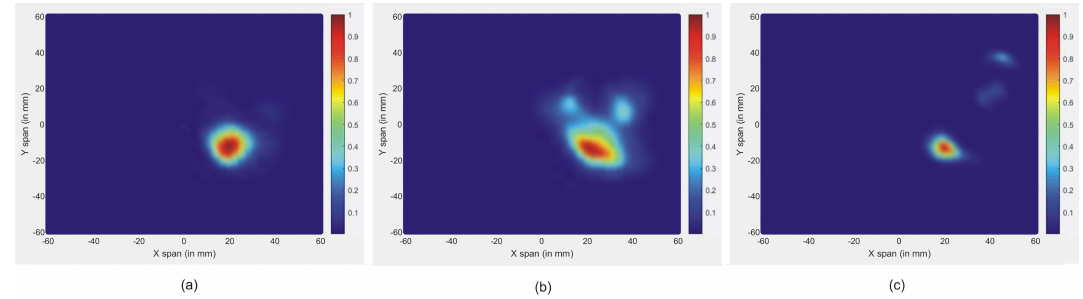
Figure 8. Reconstructed images of different tumor size: ( a ) 5 mm, ( b ) 3 mm, and ( c ) 1 mm.